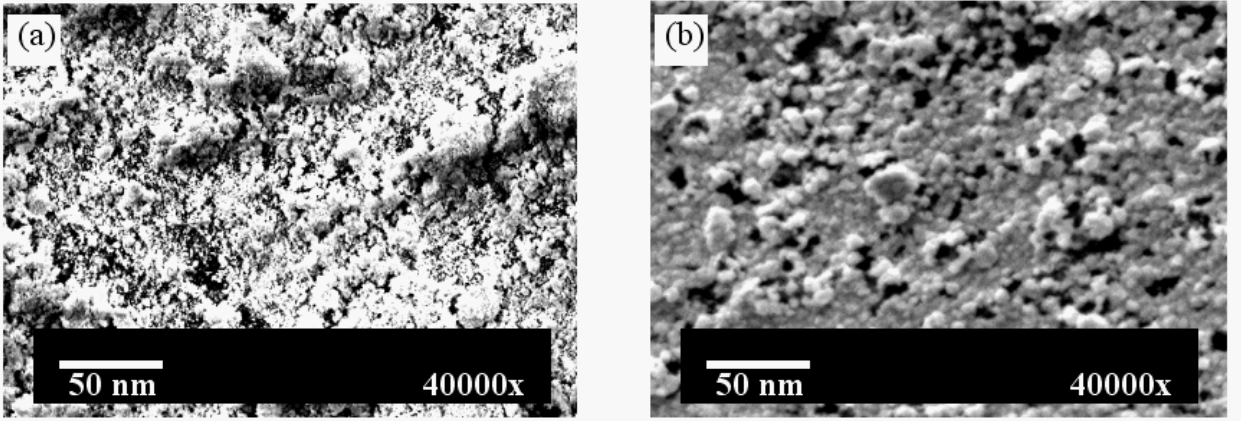
Figure 4. Scanning electron micrograph of Pt electrode deposited on Nafion117 membrane using 0.01 M Pt(NH ) Cl and reductant concentration (a) 0.01 M NaBH 3 4 2